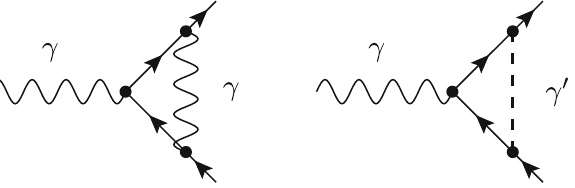
Fig. 6 Virtual diagrams contributing to γ ∗ → q ¯ q at NLO including a strictly four-dimensional photon γ ( wavy line ) and an fdf scalar γ (cid:8) ( dashed line ), respectively. Using Feynman gauge, the right diagram vanishes according to the ( − 2 (cid:3))